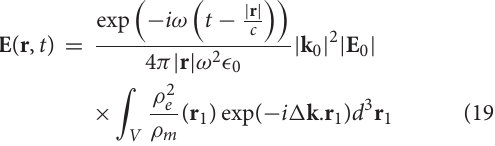
where the definition of Euler angles 8 and θ follows from Figure 2 . For an experimental setup related to the small